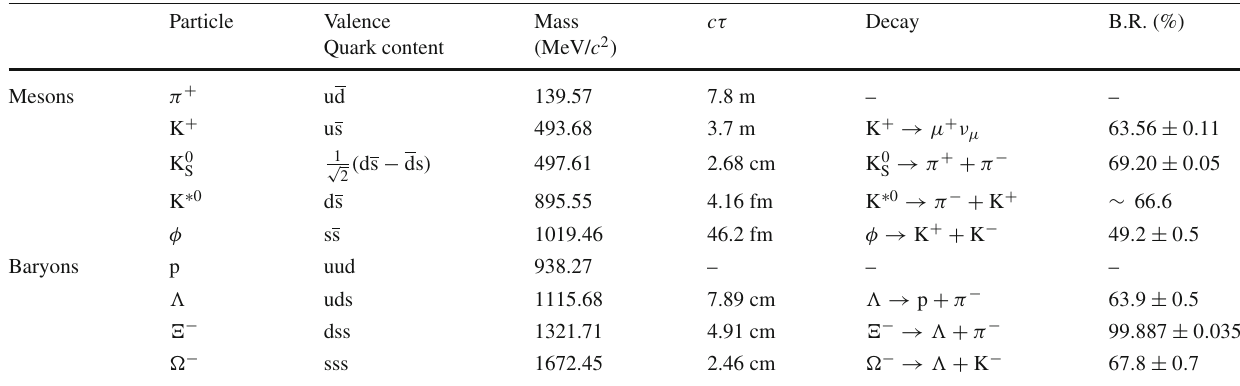
Table 1 Main characteristics of the reconstructed particles: valence quark content, mass, proper decay length ( c τ ), the decay channel studied in this paper, and the corresponding branching ratio (B.R.) [44] Particle